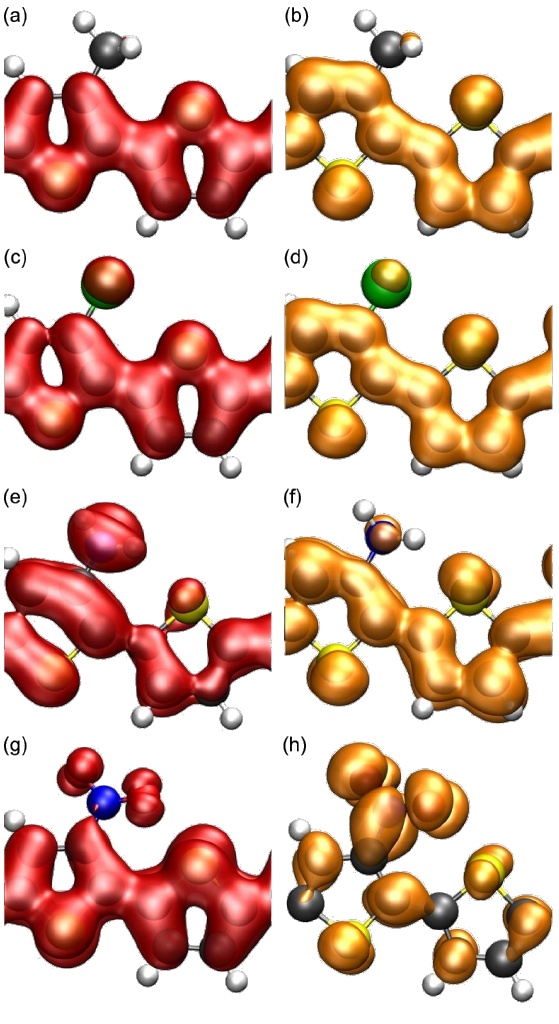
to significant changes in both the HOCO and the LUCO although it only caused minor changes of the band structure. It has been suggested that one assumes a similar energetic shift of both orbitals for π -donating/accepting substituents resulting